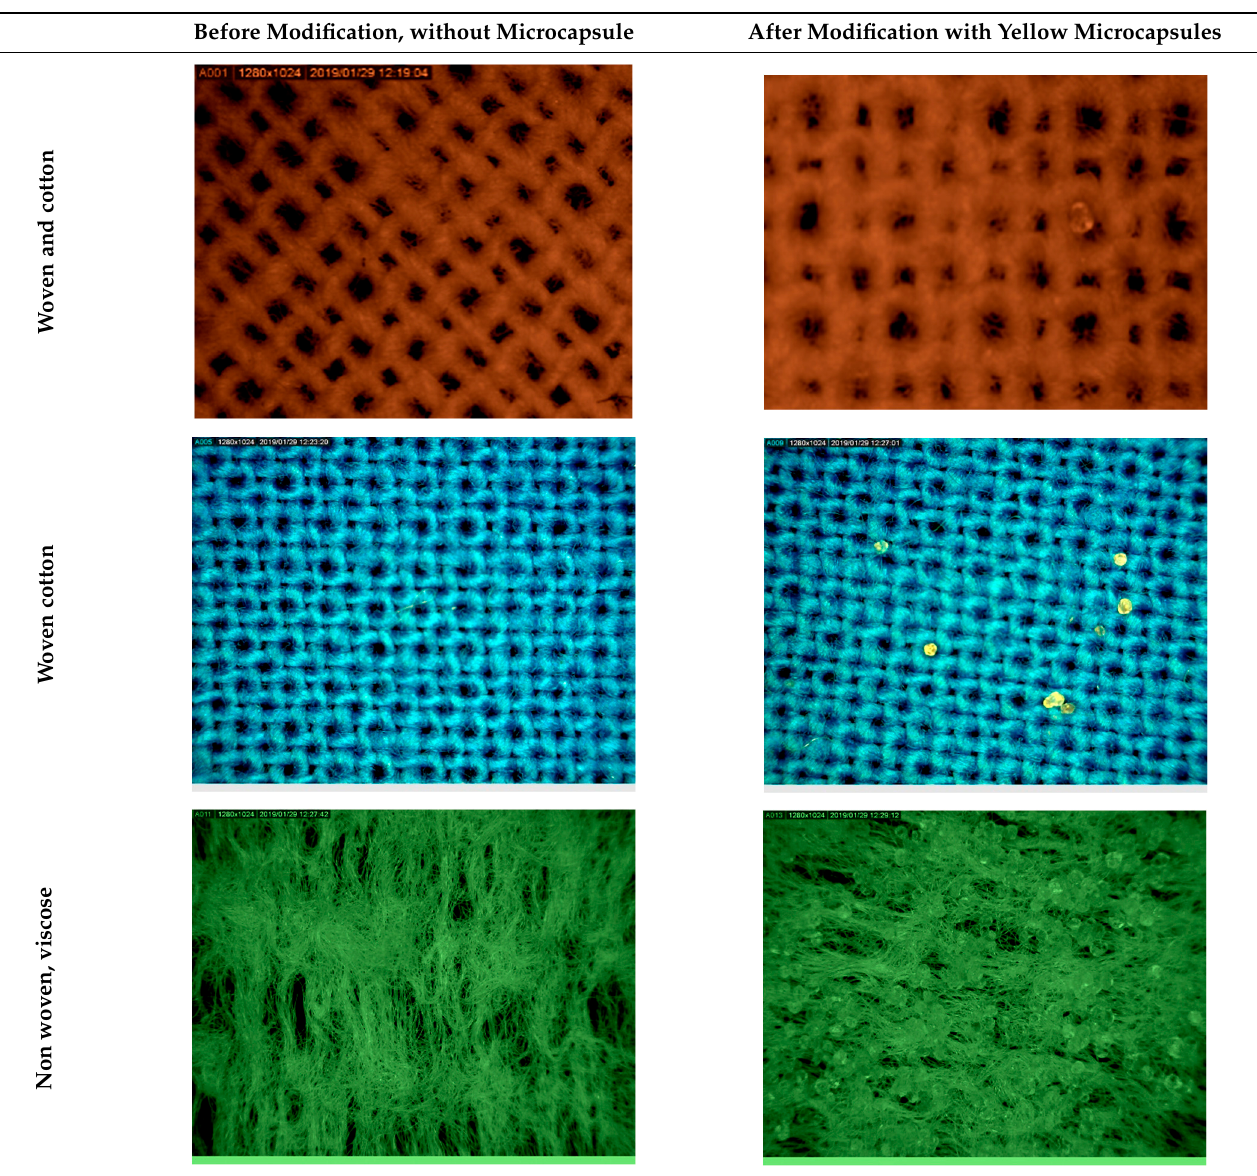
Table 3. Microphotograph of the samples after dip-coating functionalization (woven and non-woven cotton and viscose polymers).